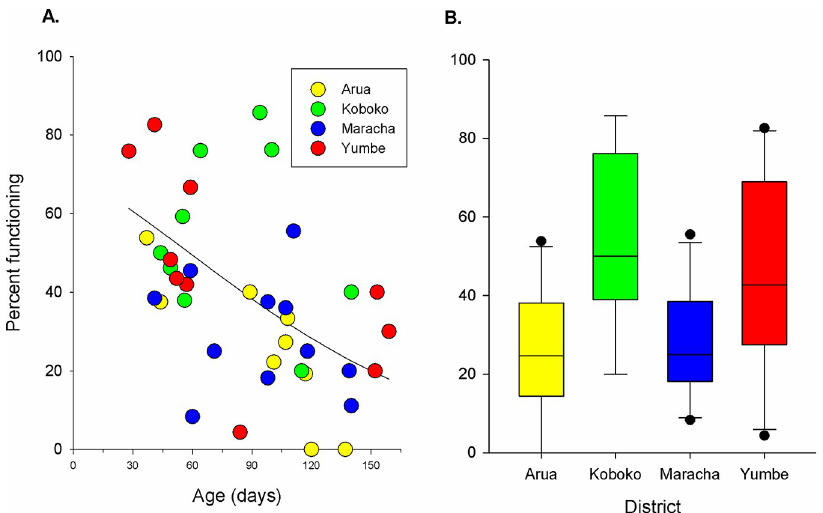
Fig 7. (A) Scatterplot of percentage of targets functioning against age (days since deployment) and (B) boxplot of percentage functioning for each district.